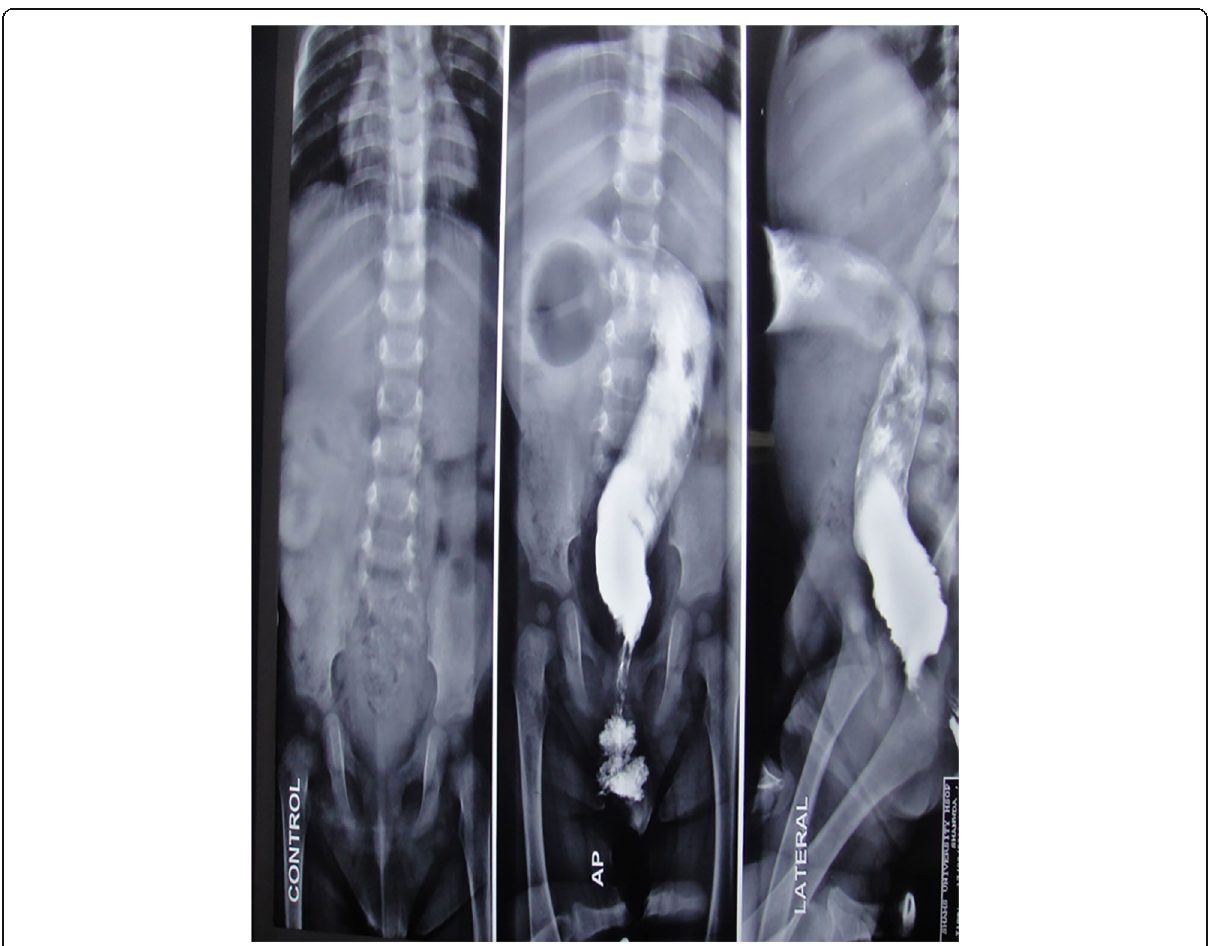
Fig. 3 Gastrografin enema of a child after abdominal Soave showing a long